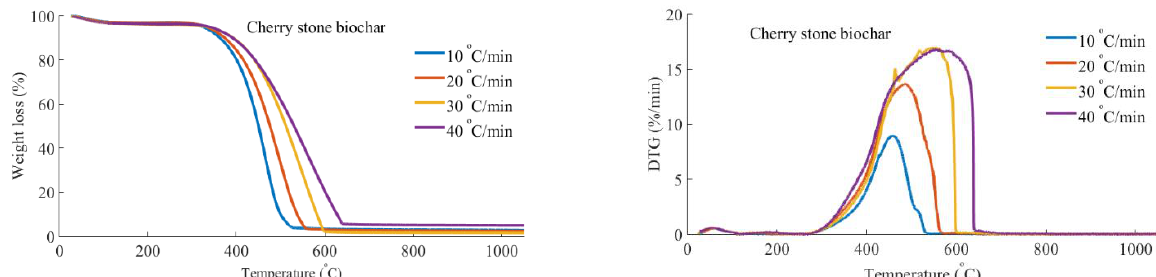
Figure 3. Effect of heating rate on cherry stone biochar oxidation, TGA and DTG in air.